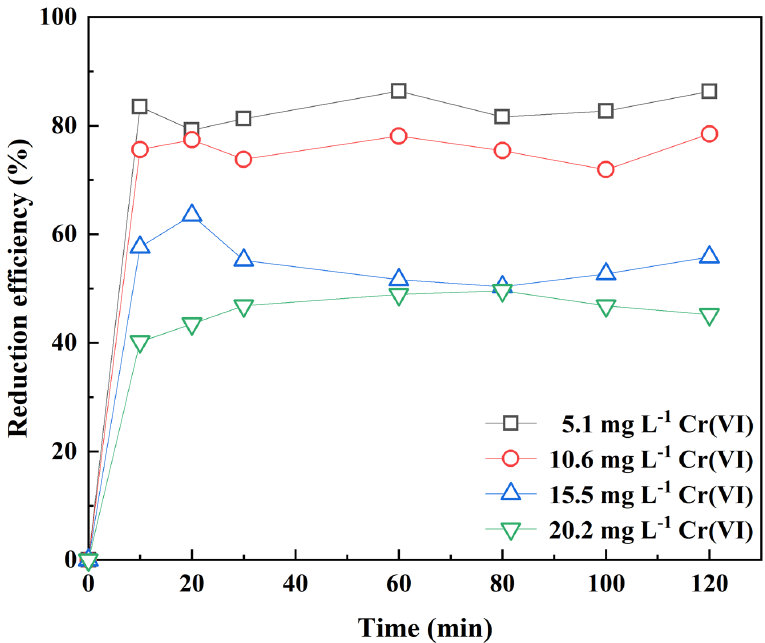
Figure 8. Effect of initial Cr(VI) concentration on the Cr(VI) reduction by RC-nZVI.